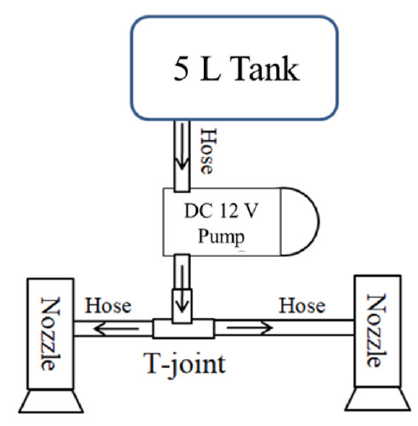
Figure 7. The spray system of the UAV.